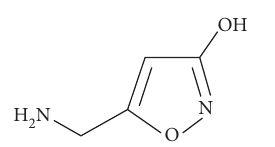
Figure 1: Muscimol (5-(aminomethyl)-isoxazol-3-ol).